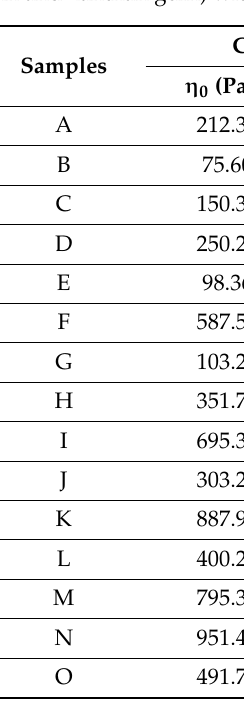
Table 3. The results of fitting data of emulsions containing two hydrocolloids (fenugreek galactoman- nan and xanthan gum) with the Carraeu